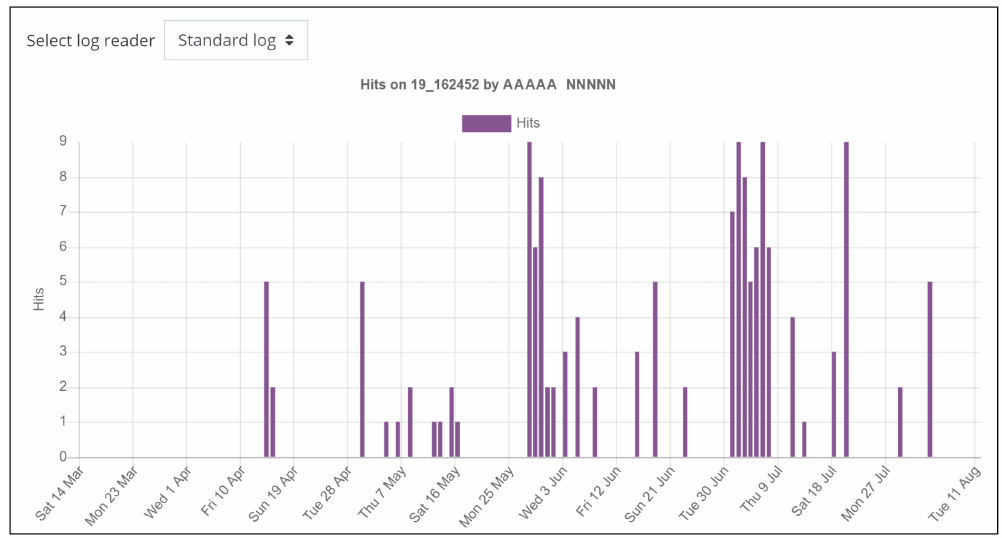
Figure 1. Traditional log activity report chart from a Moodle